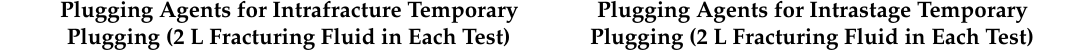
Table 2. Experimental scheme of the temporary plugging fracturing in a horizontal well with multi- stages and